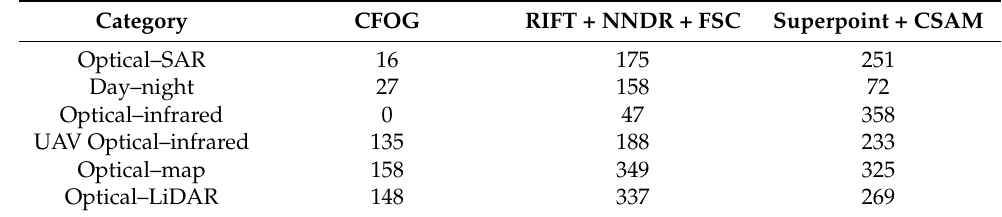
Figure 15. Test image pairs.